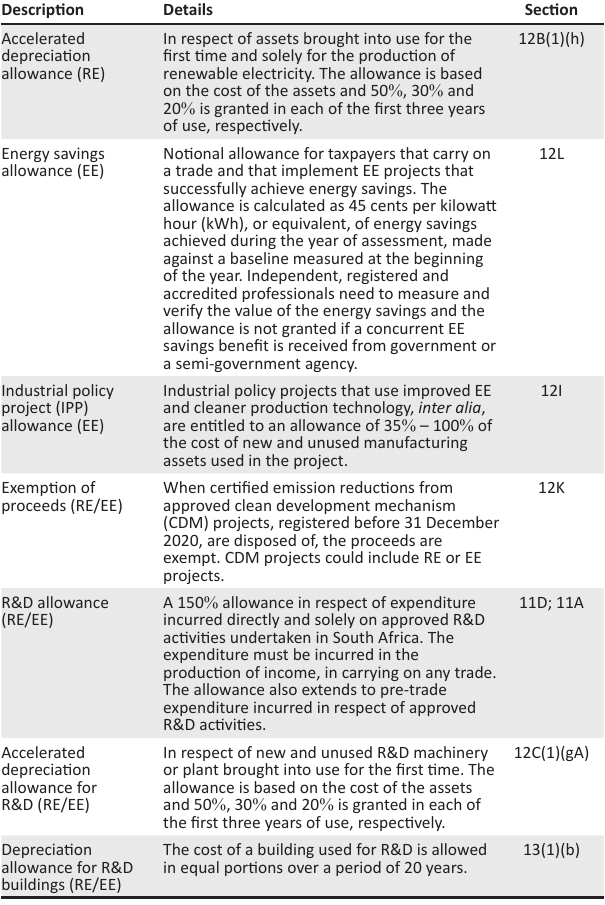
TABLE 1: Energy efficiency or renewable energy tax incentives in South Africa.